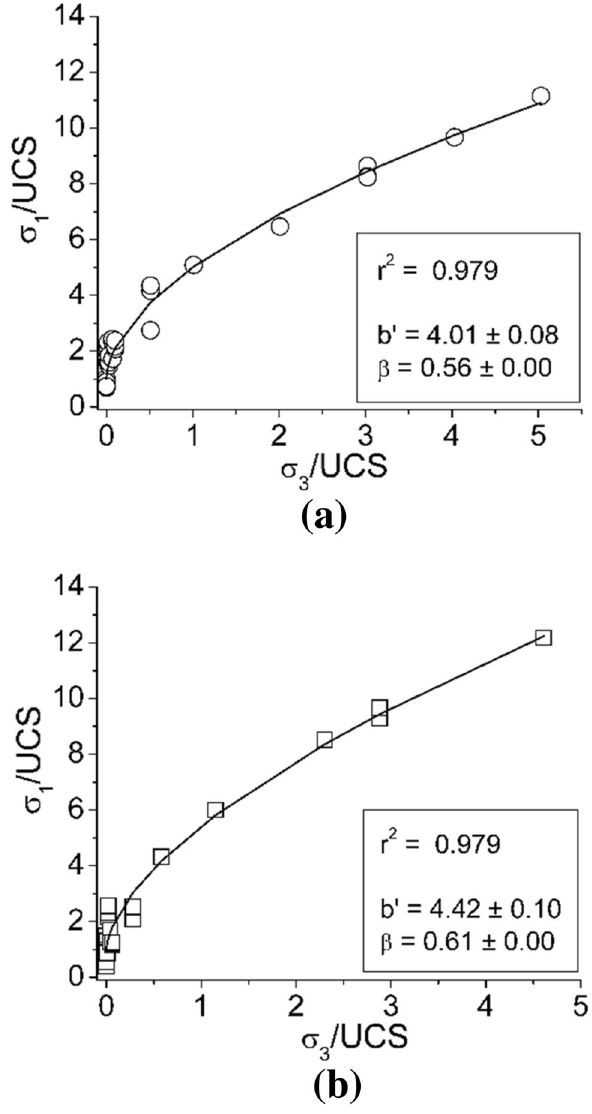
Fig. 11 Results of the triaxial compressive tests fitted with the Moomivand & Vutukuri’s approach on the geometry effect of pillar ( a 0 (cid:3) of the included angle and b 30 (cid:3) of the included